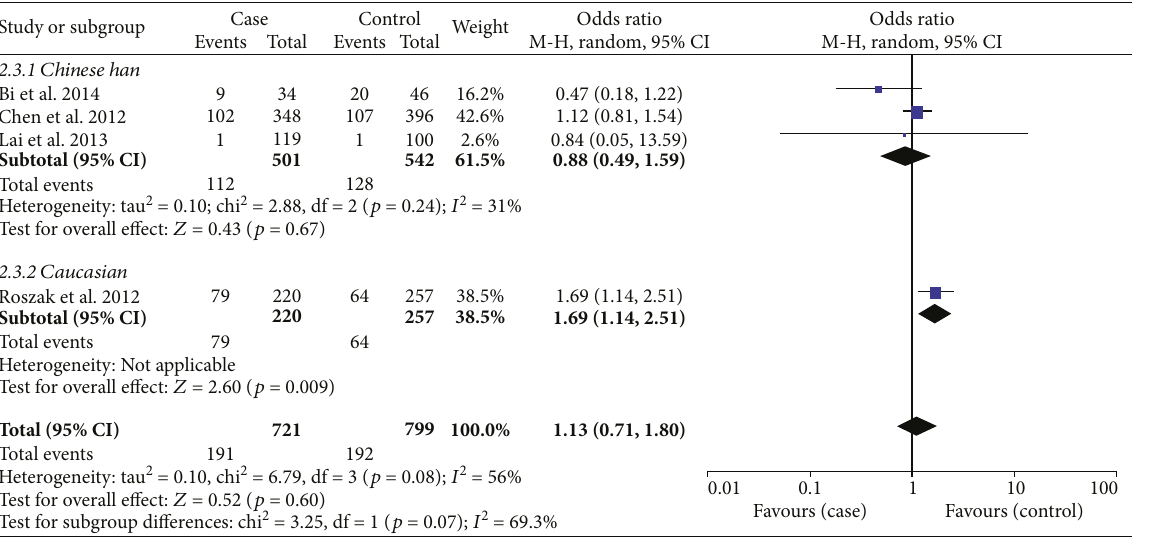
Figure 6: Subgroup analysis of the association between TLR9 rs187084 polymorphism and cervical cancer risk strati fi ed by race in the homozygous genetic